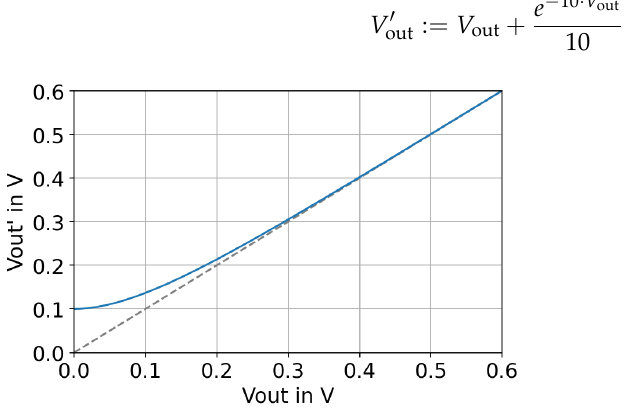
Figure 4. Substitution of V out with V (cid:48) out by adding an exponential decaying